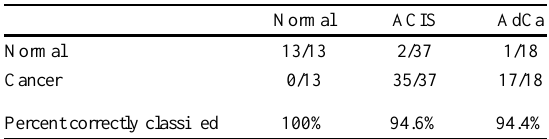
Classification results by tissue